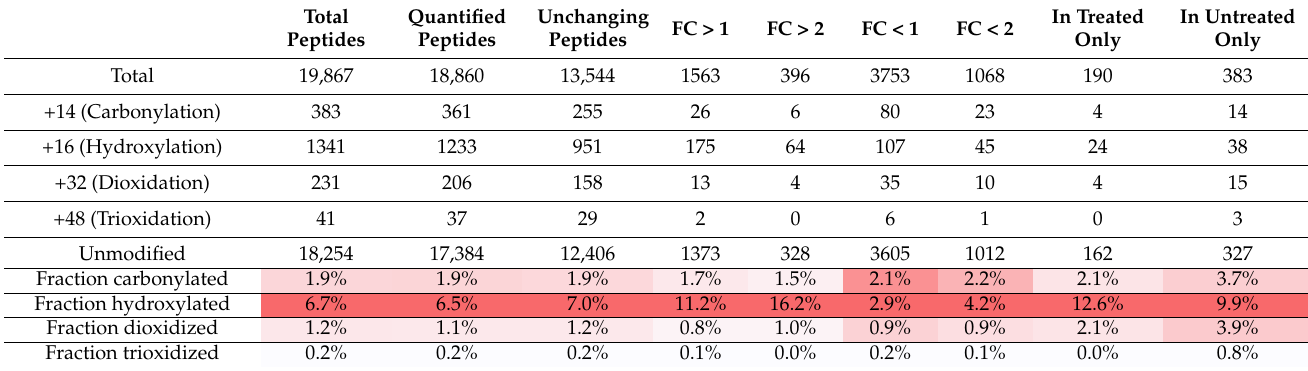
Table 2. Observed peptide oxidation for IR9-150-1 (3 kGy:0 Gy) bacterial strain. Total Peptides